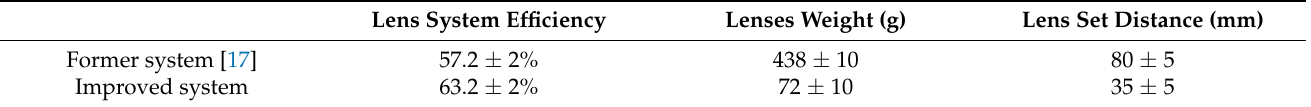
Table 3. Simulated efficiency at 1 m and measured parameters of a 3-LED-OWPT system.